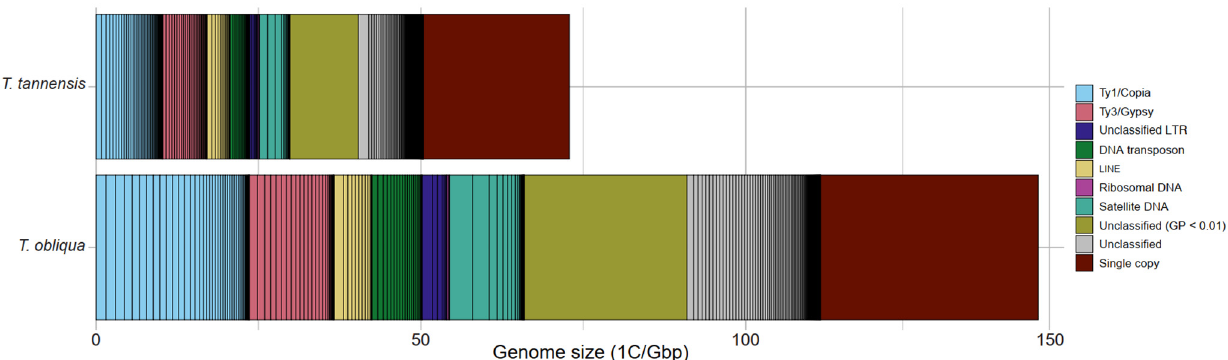
Figure 1. Genomic repeat composition of T. tannensis and T. obliqua . Genomic proportions (GP) in Gbp/1C are colored by repeat class. The vertical black lines within each repeat class indicate the genomic abundances of particular variants of repeats, as identified from individual RepeatExploer2 clusters. ‘Unclassified’ refers to those repeats that are unidentified with a genomic proportion ≥ 0.01%, while ‘Unclassified (GP < 0.01)’ refers to reads that are part of repeated elements with a genomic proportion below 0.01%.